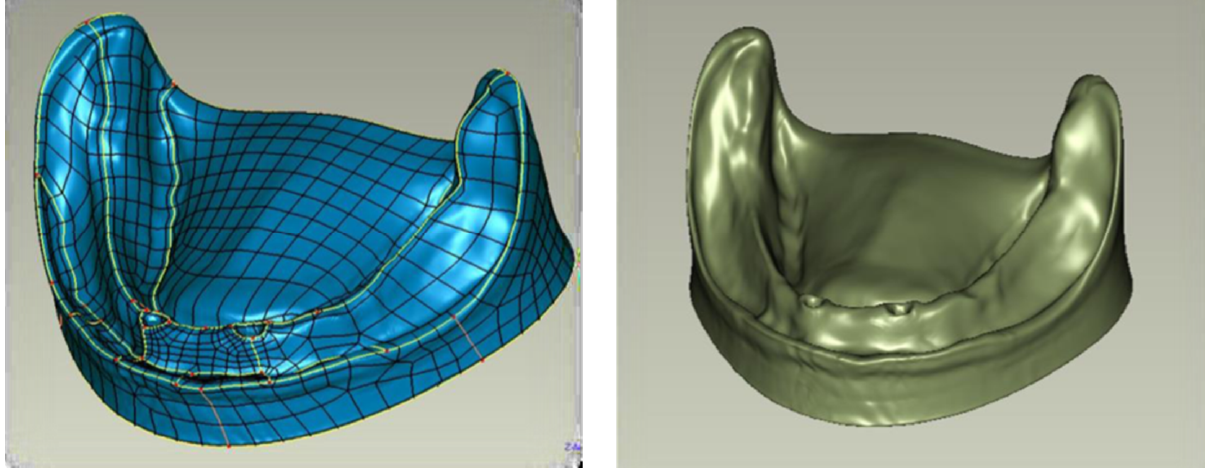
Figure 4. Division of mandibular mucosa into areas and final model defined with NURBS surfaces. To generate NURBS surface, contours along with division lines of particular areas of the mandible were determined. These measures allowed the surface formation of the model to be controlled